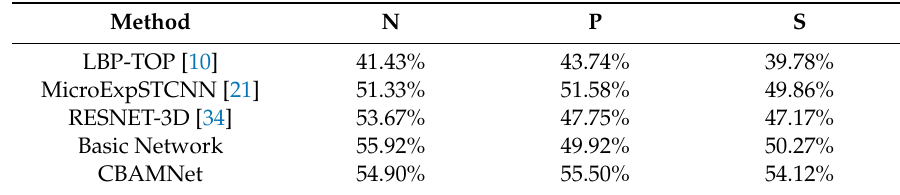
Table 9. Comparison of di ff erent methods on